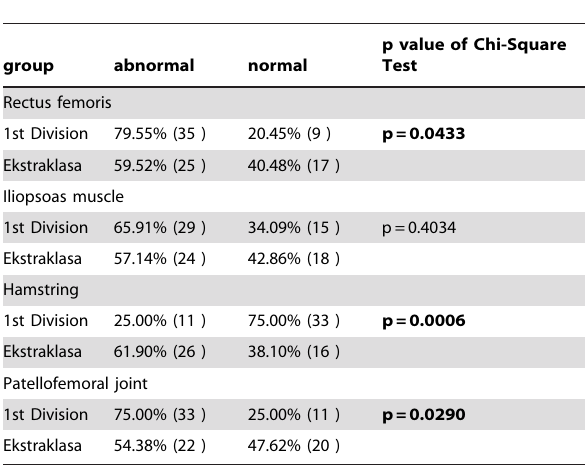
Table 5. Relationships between the player’s level of training and normal and abnormal results recorded during the assessment of muscle length and patellofemoral joint